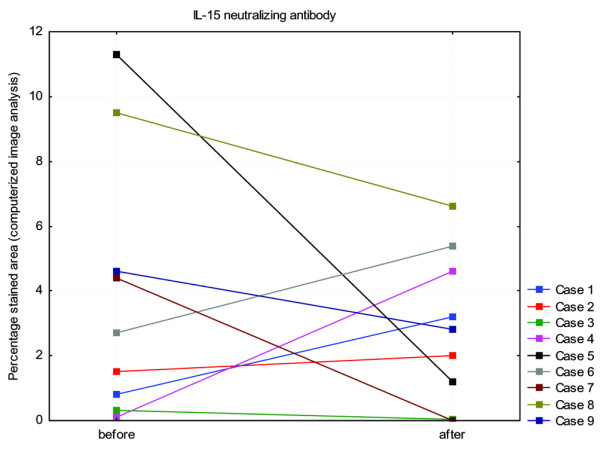
Expression of IL-15 before and after treatment with infliximab. Shown is the expression of IL-15, analysed with the IL-15 neutralizing antibody, in the synovial tissue of nine patients with rheumatoid arthritis before and after treatment with infliximab. The percentage of positively stained tissue area, analysed by computerized image analysis, is presented. No significant difference was observed.